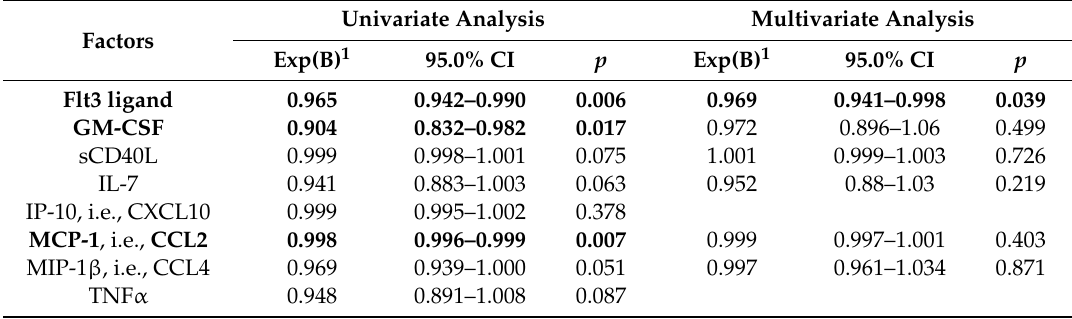
Table 5. Results of regression analysis regarding correlations of cytokines / chemokines with IHD risk.